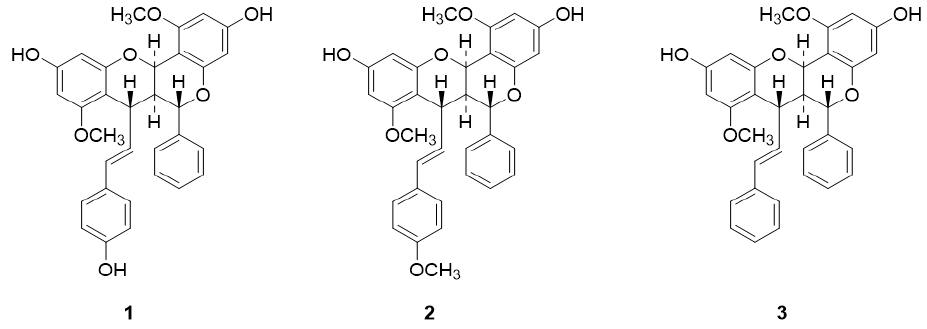
Figure 1. Structure of the tested compounds, Brachydin A ( 1 ), Brachydin B ( 2 ), and Brachydin C ( 3 ).